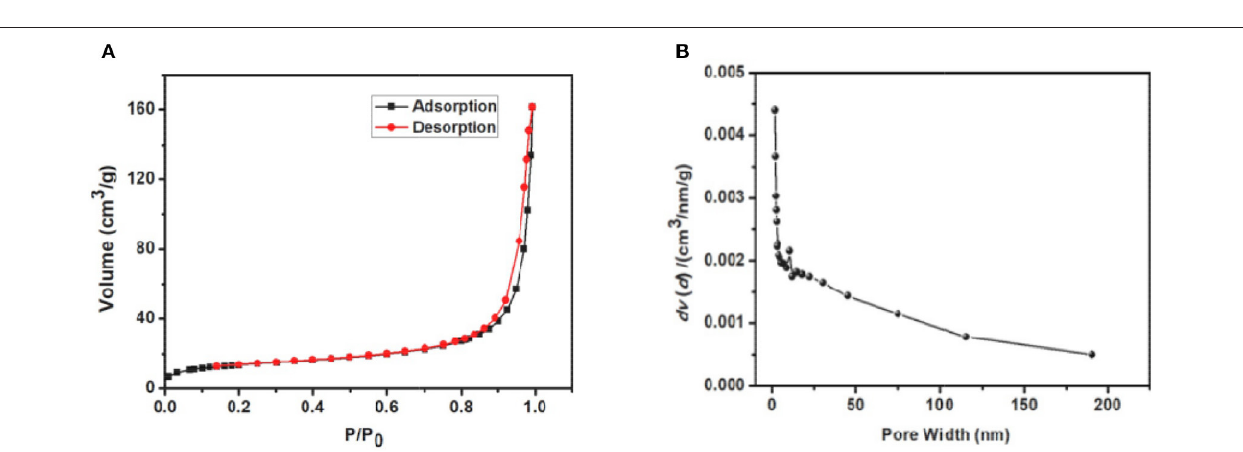
conducted at room temperature. As shown in Figure 4A , at first, a substantial number of active sites were exposed on the surface of JLUE-COP-3, the adsorption rate sharply rised in the first 24 h; with the passage of time, the active sites and the pores were